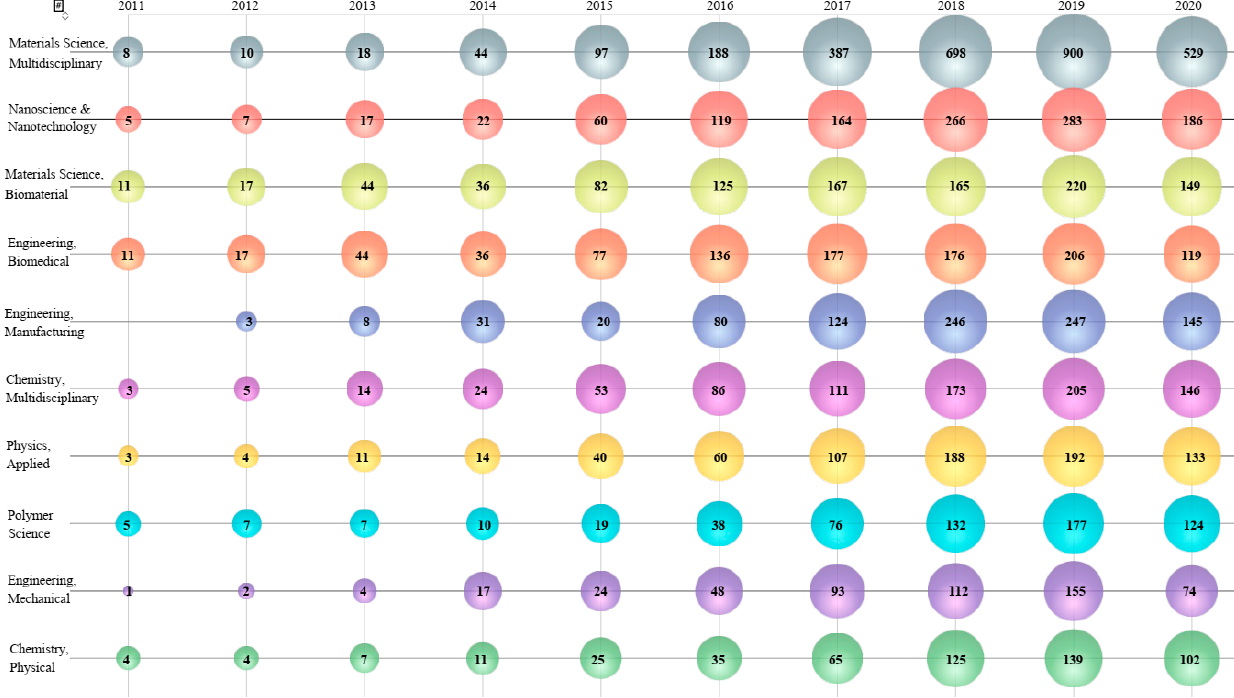
Figure 14. Research areas bubble chart of the publications citing the reviews on topic of 3D printing. Table 7. Reviews on topic of 3D printing.